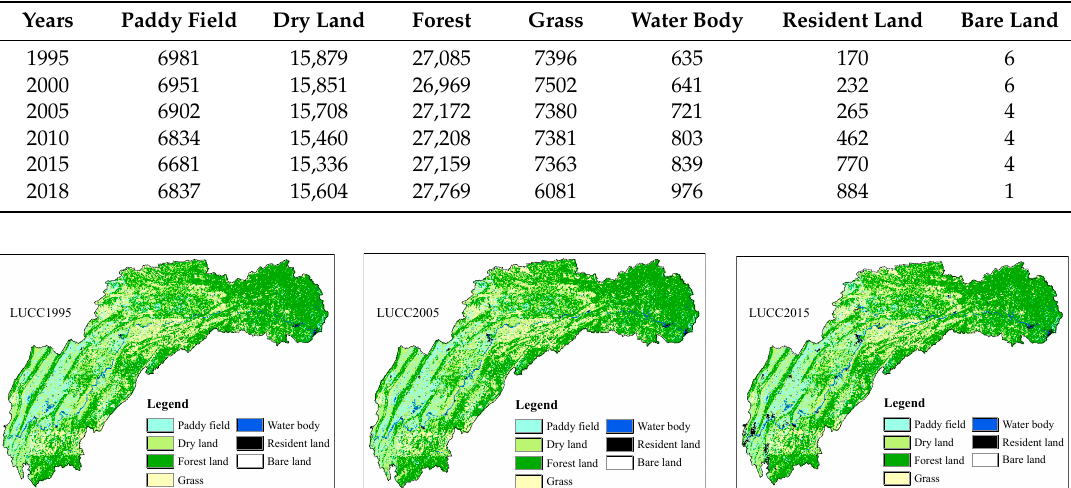
Figure 2. Land use classification map of the study area in 1995, 2005 and 2015.